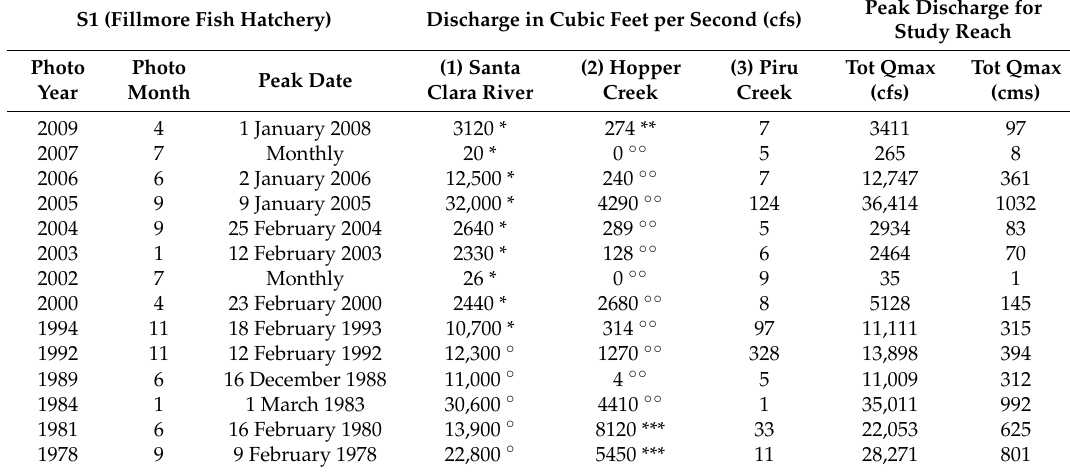
Table A1. Calculated values for magnitude of peak discharge for specific flooding events at S1 study site.